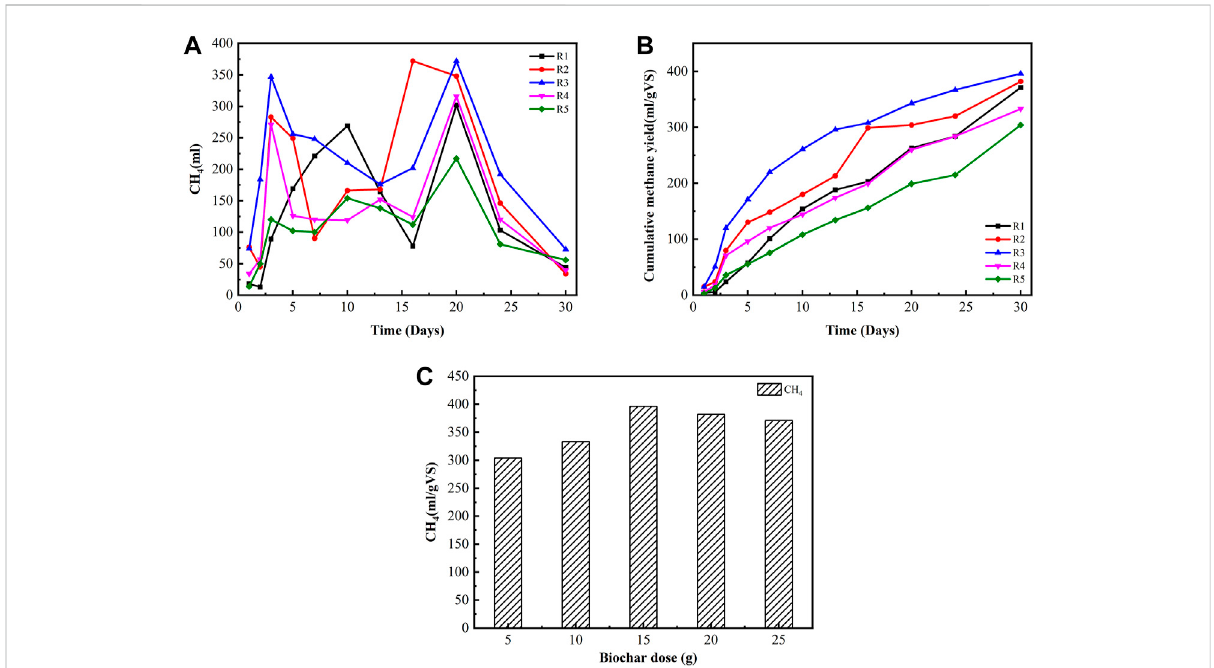
FIGURE 2 Daily methane production, cumulative methane yield, and speci fi c methane yield production with different biochar doses under mesophilic temperature. (A) Daily methane production. (B) Cumulative methane yield. (C) Speci fi c methane yield at different biochar